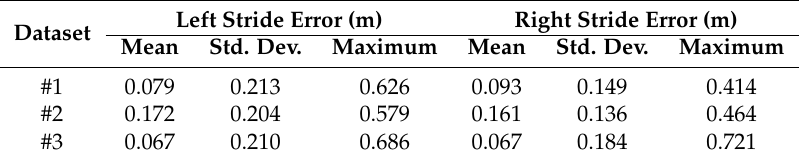
Figure 18. Foot stride length error. Table 6. Error statistics of foot stride length computed by strapdown